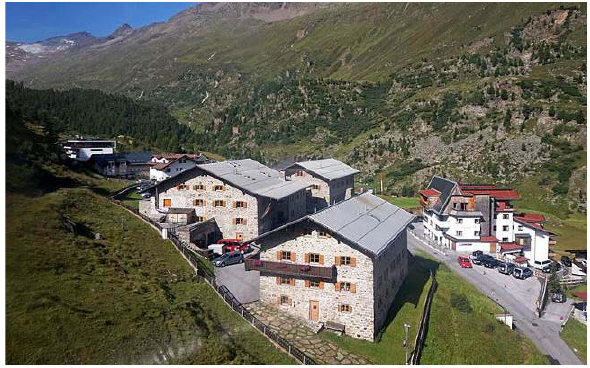
Figure 1. Location of the summer school venue University Centre Obergurgl (Austria) (Tina Monto CC BY-SA